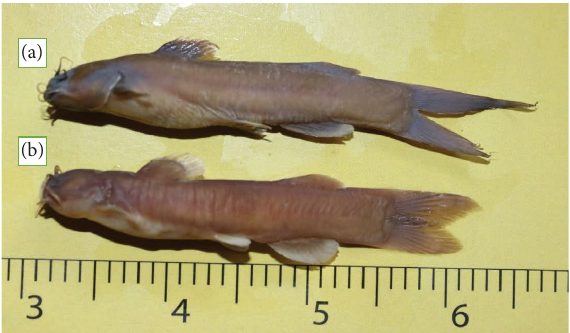
Figure 3: Photographic comparison of (a) A. waikhomi and (b) A.